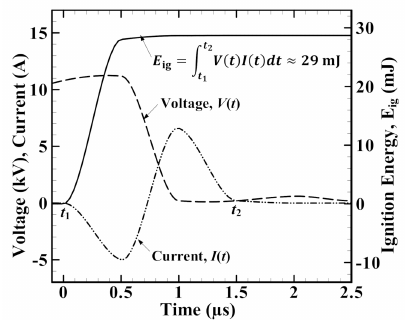
(cid:82) t 2 V ( t ) I ( t ) dt ≈ t 1